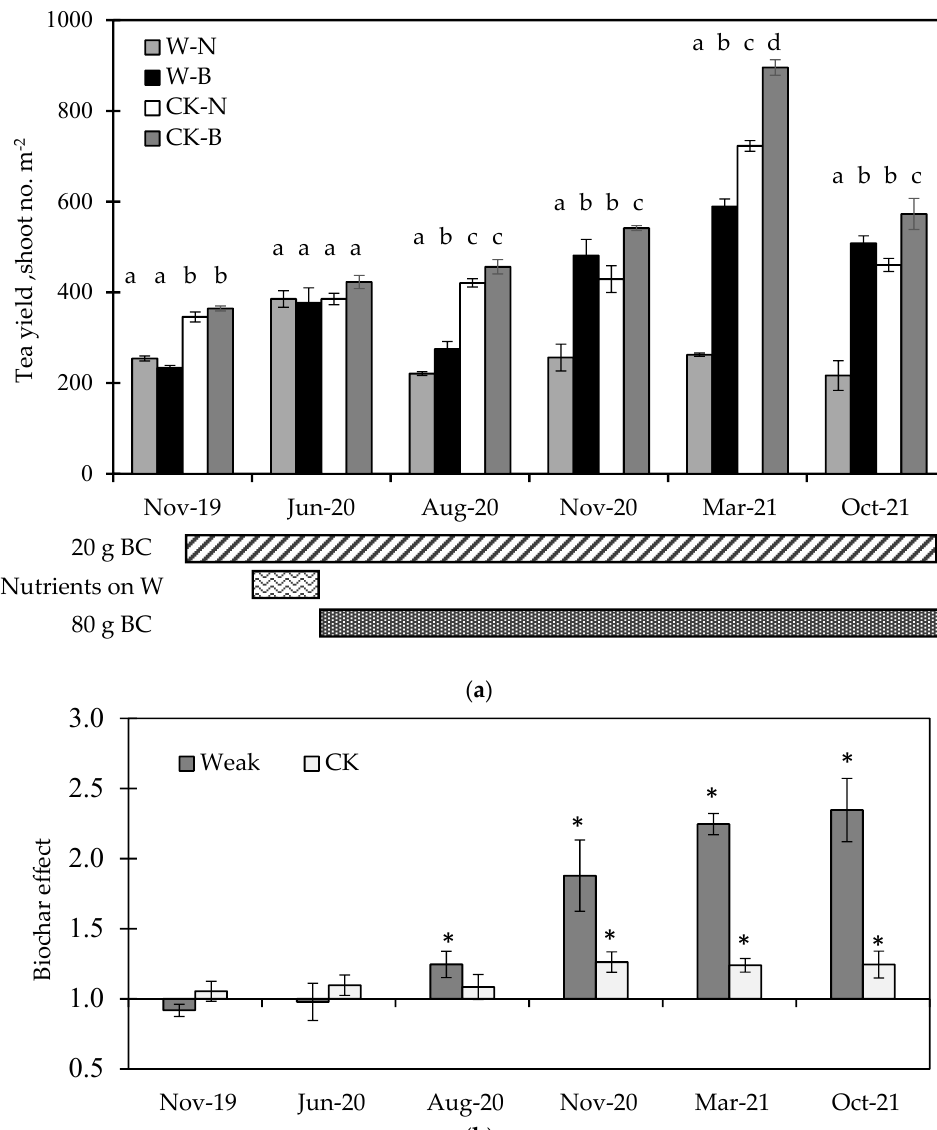
Figure 2. The differences between blocks of weak tea growth and normal (CK) in soil characteristics and tea yield are shown in ( a ). Bars represent the standard error of the mean ( n = 6), where the signs of * indicate a significant difference between blocks of weak and CK with the Student’s t -test. The variation in soil pH in blocks of weak and CK is shown in ( b ).